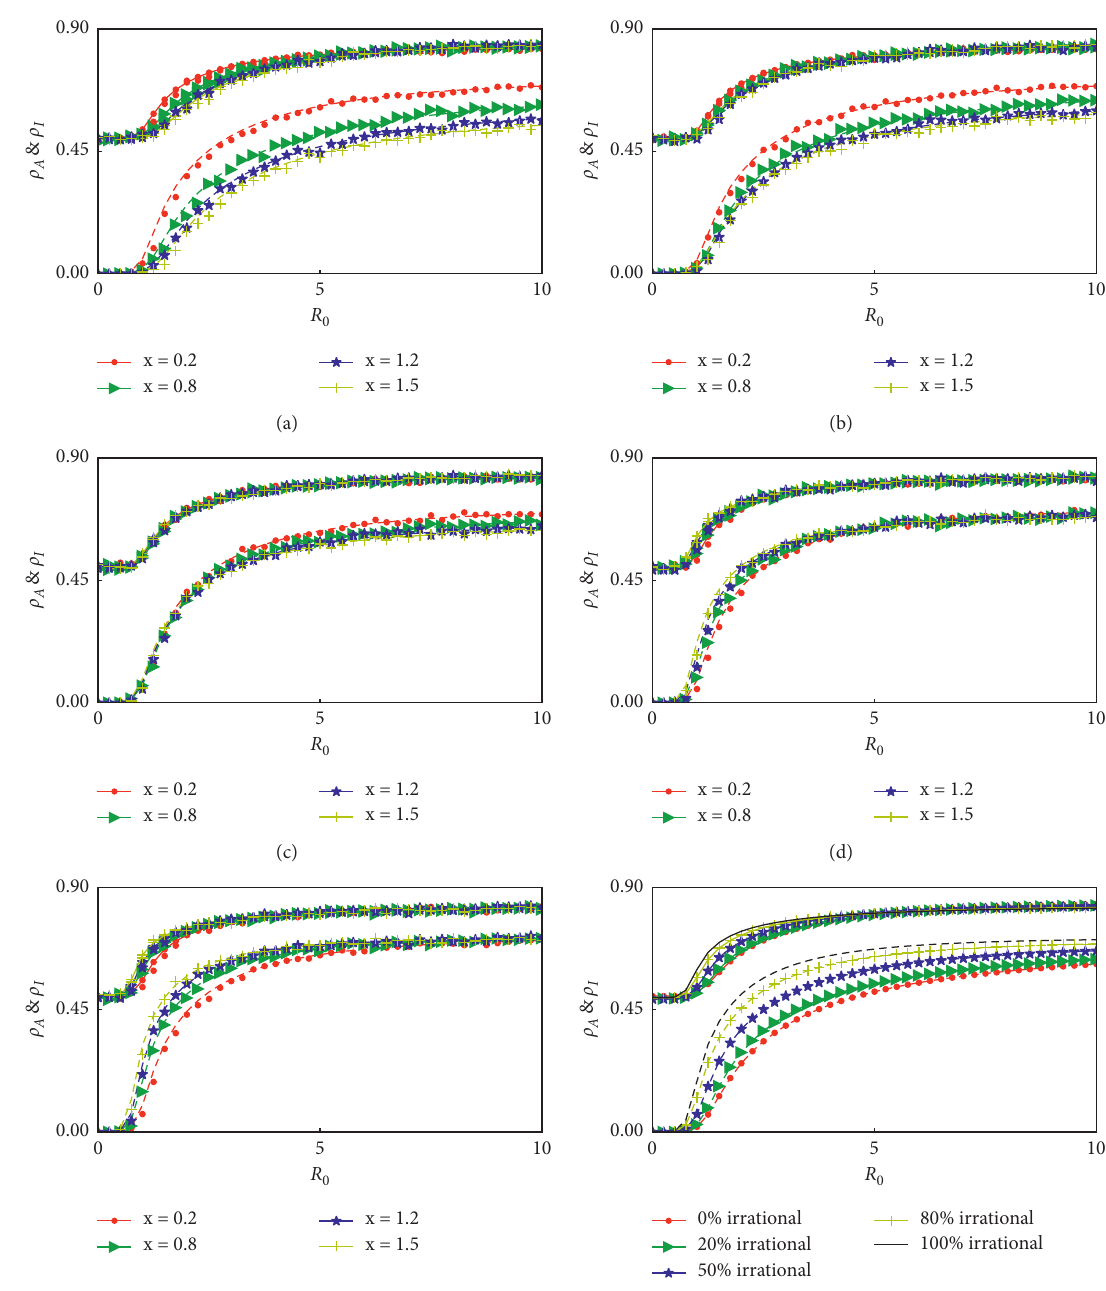
Figure 6: For the first form of dependence, where c � ( 1 − ρ dependence of prevalence ρ A and prevalence ρ I on the infection rate R irrational individuals. Solid lines represent the ratio of awareness nodes ρ A and dashed lines represent the ratio of infected nodes. Symbols represent the simulation results and different colors correspond to different x values. (f) Comparison between cases of different ratios of irrational individuals, with x � 0 . 8. All calculations are based on δ � 0 . 6 and μ � 0 .